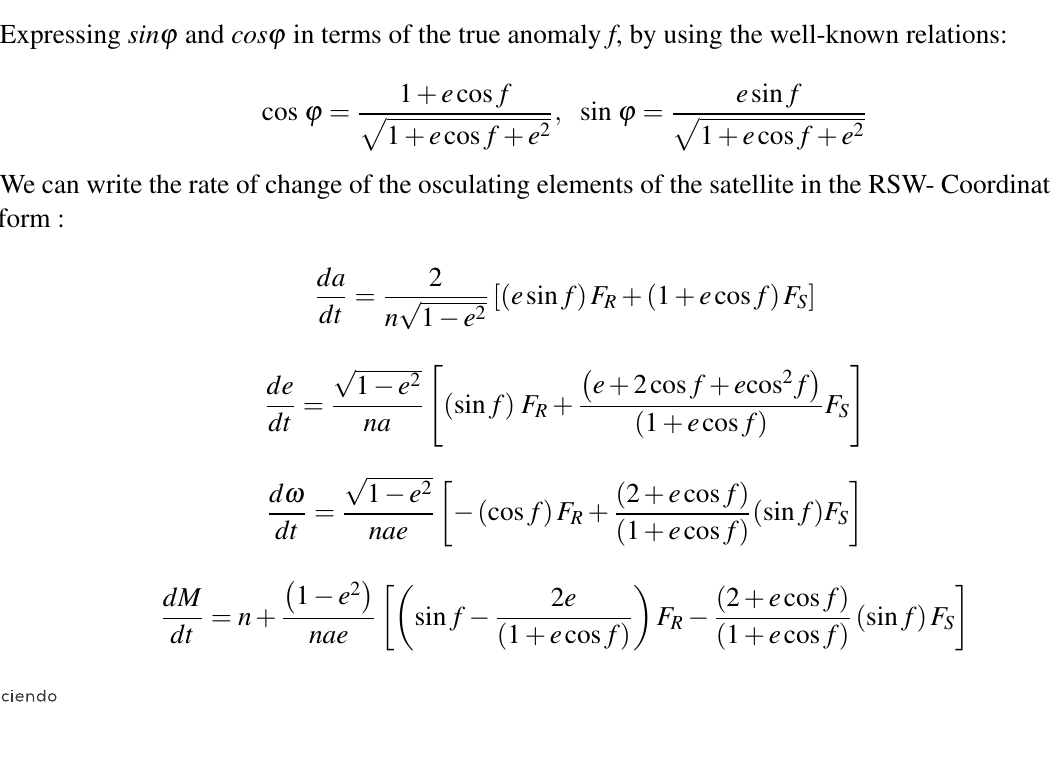
Fig. 2 The relation between RSW and TNW-Coordinate